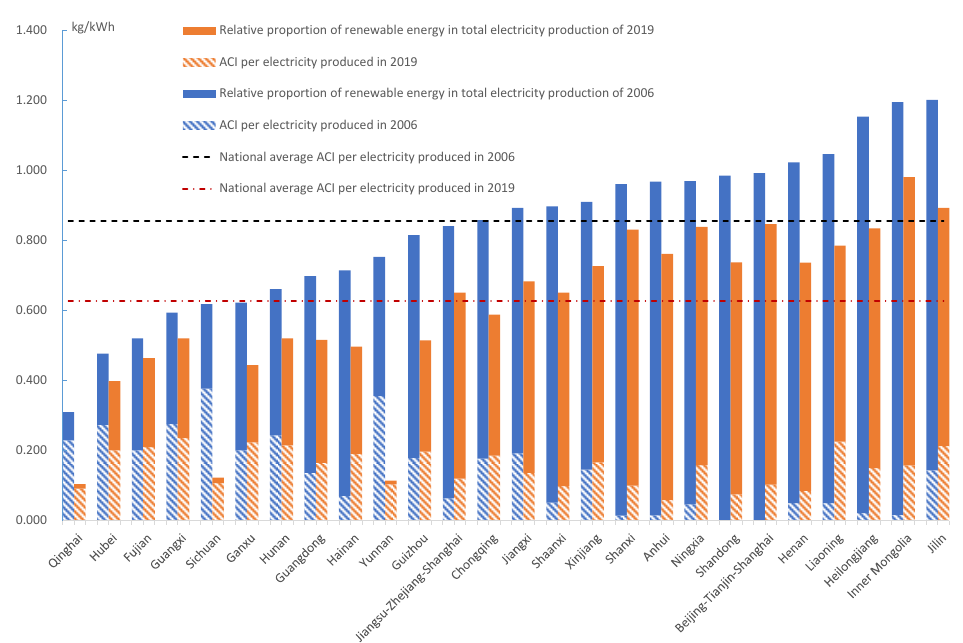
Figure 4. ACIP and proportion of renewable energy of Chinese mainland provinces, 2006 and 2019 (No data for Tibet).